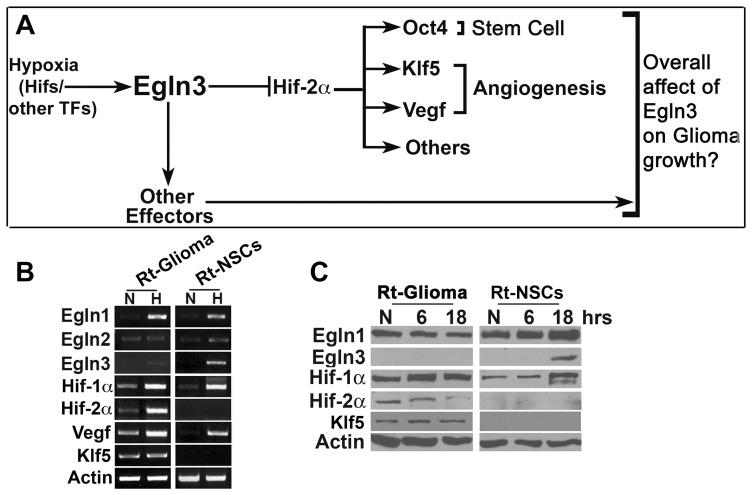
Hypoxic expression profile using a Rat glioma cell model.(A) Model for Egln3 function in glioma. (B, C) Rt-glioma cells or Rt-NSCs were subjected either to atmospheric O2 levels, normoxia (N) or to 1% O2, hypoxia (H) for the indicated time. mRNA (B) and protein (C) expression analysis of Egln1 Egln3c, Hif-1α, Hif-2α and Klf5 by RT-PCR and Western. β-actin served as a loading control.